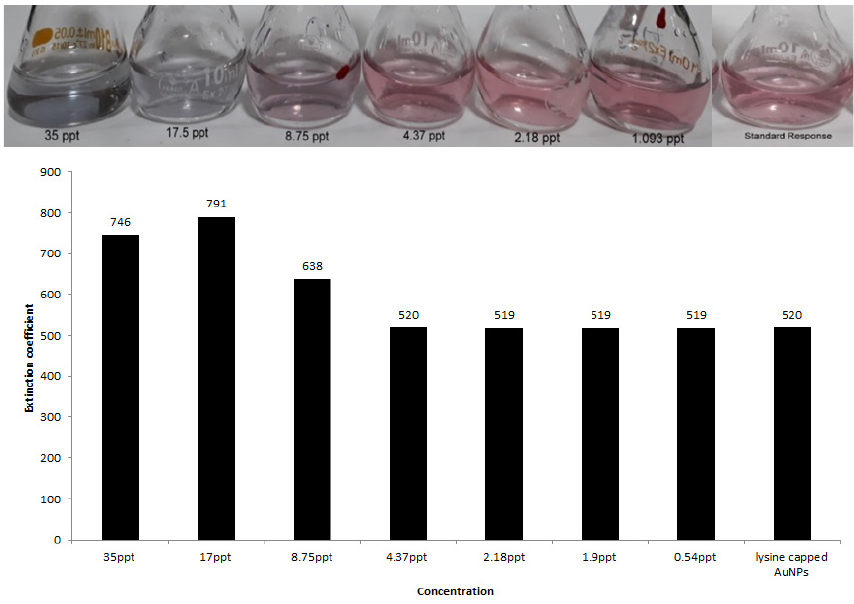
Fig 5. Matrix matching indicating optimum salt concentration of sea water for sensor